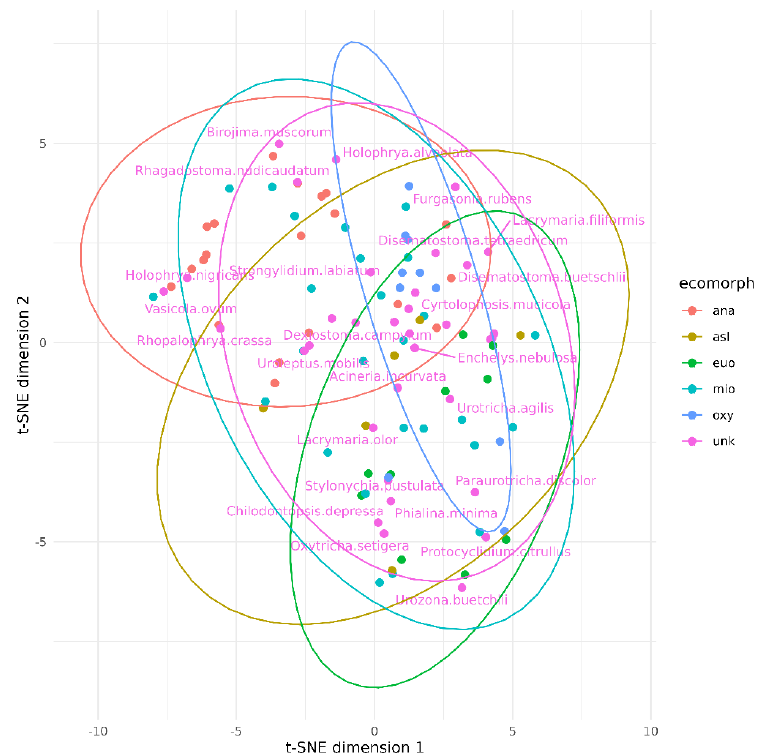
Figure 8. The t – SNE of ciliate species based on habitat distribution (sapropel, water, plants). Eco- morphs of ciliates: ana, anaerobic; asl, “activated sludge” group; euo, euryoxyphilic; mio, microox- yphilic; oxy, oxyphilic; unk, species with unknown preferences.